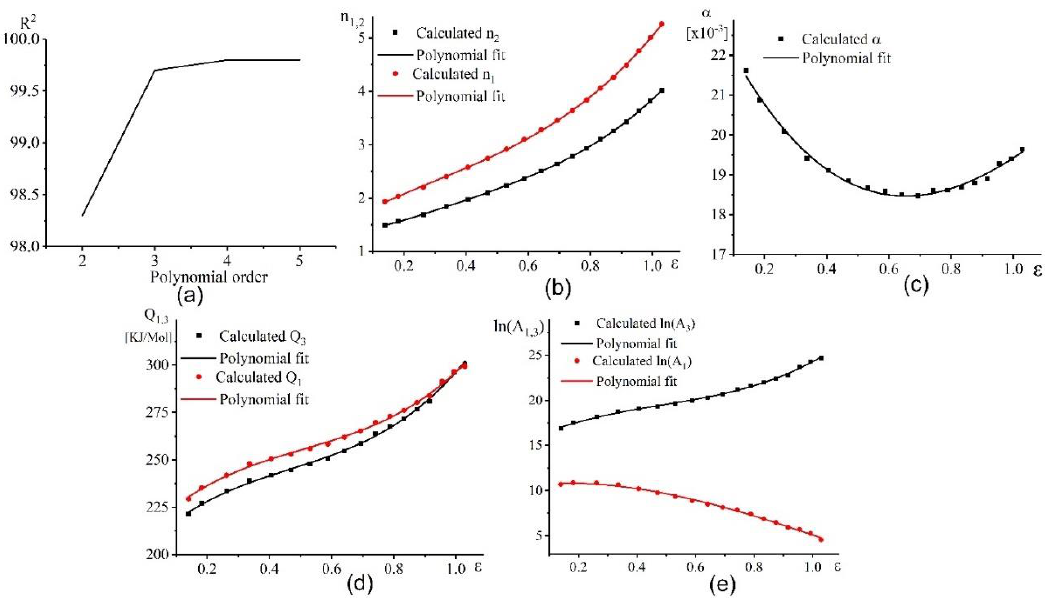
Figure 9. ( a ) Root mean square vs. the polynomial order, ( b ) variation of n1,2 vs. true strain ( c ) variation of α vs. true strain, ( d ) variation of Q 1,3 , vs. true strain, and ( e ) variation of ln(A1,3) vs. true strain ( ε ). Table 3. The coe ffi cients of the polynomial fitting for α , n2, A3, and Q 3 and the R 2 for this